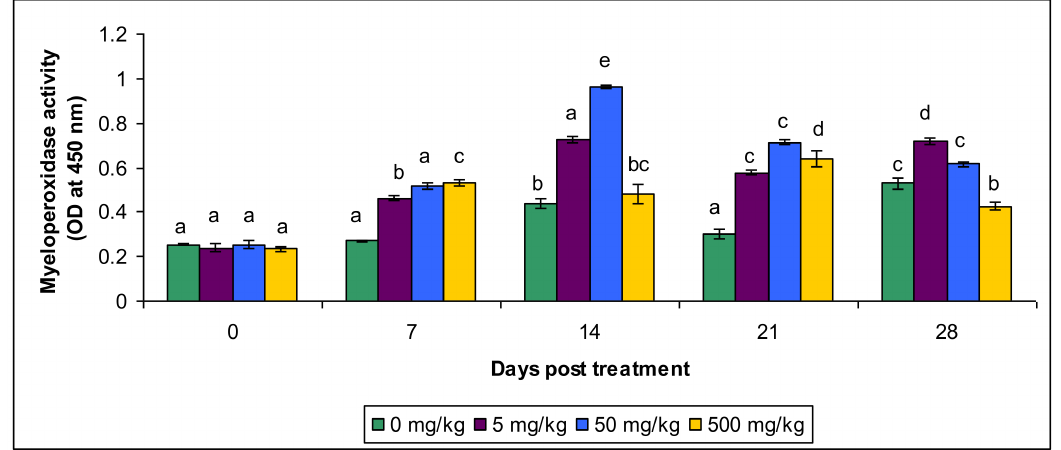
Figure 3. Serum myeloperoxidase activity under different treatments administered with various levels of C. aerea extract in L. rohita during post treatment days (values are mean ± SE). Mean values with different superscript within a column for a parameter are significantly different ( p <